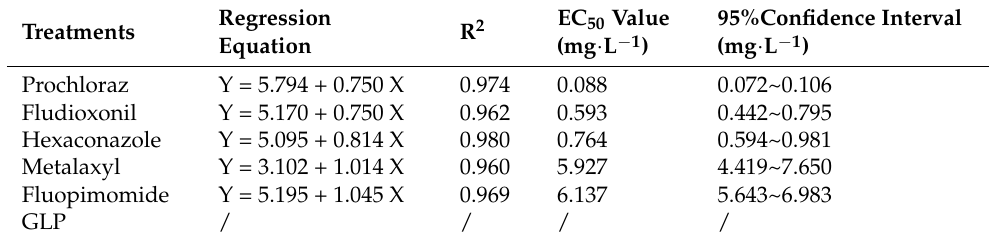
Table 2. In vivo assays test of GLP and fungicides on Fusarium graminearum .